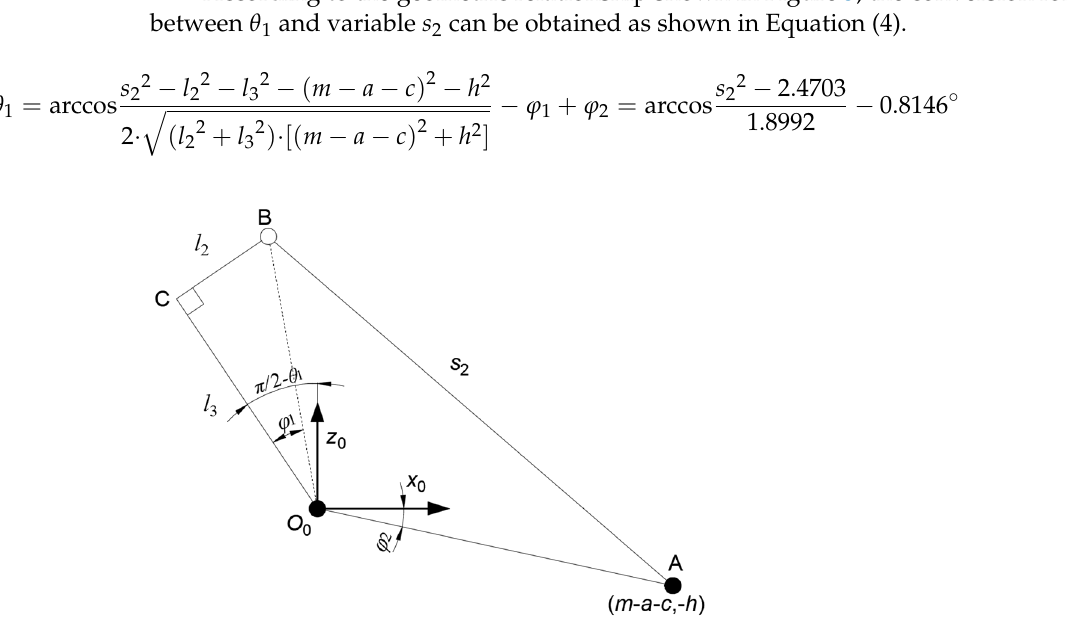
Figure 5. Analysis model of the single-leg mechanism.